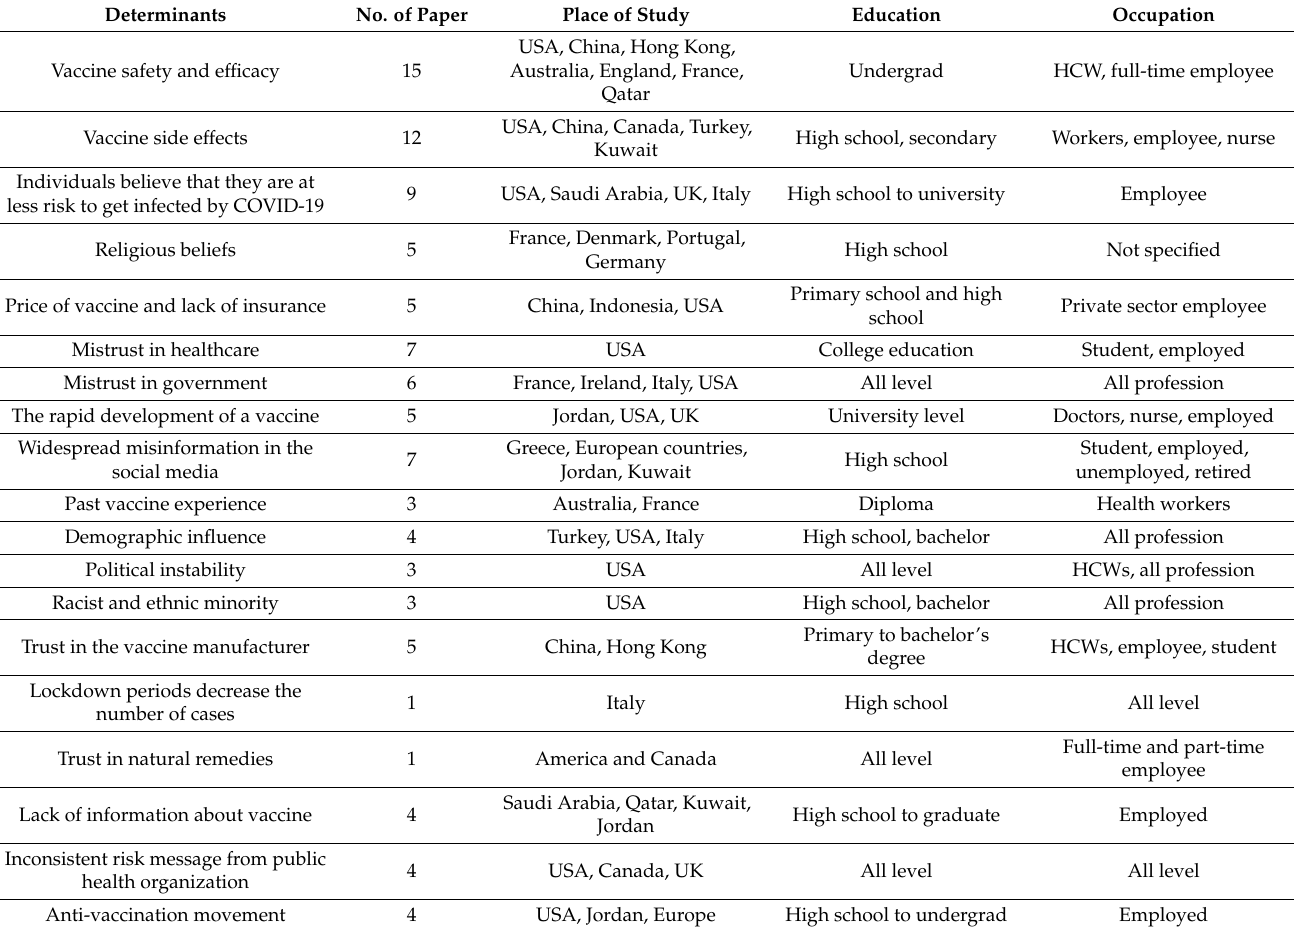
Table 4. Determinants of COVID-19 vaccine